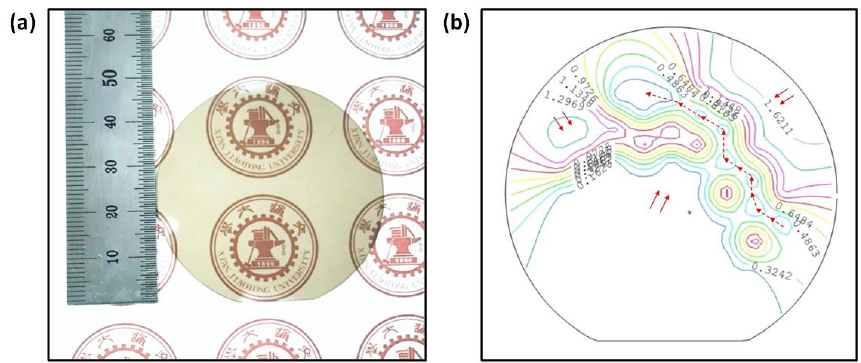
Figure 2. ( a ) Two inch wafer − scale film on sapphire with the thickness of 150 nm. ( b ) The square resistance mapping during the growth of thin film.